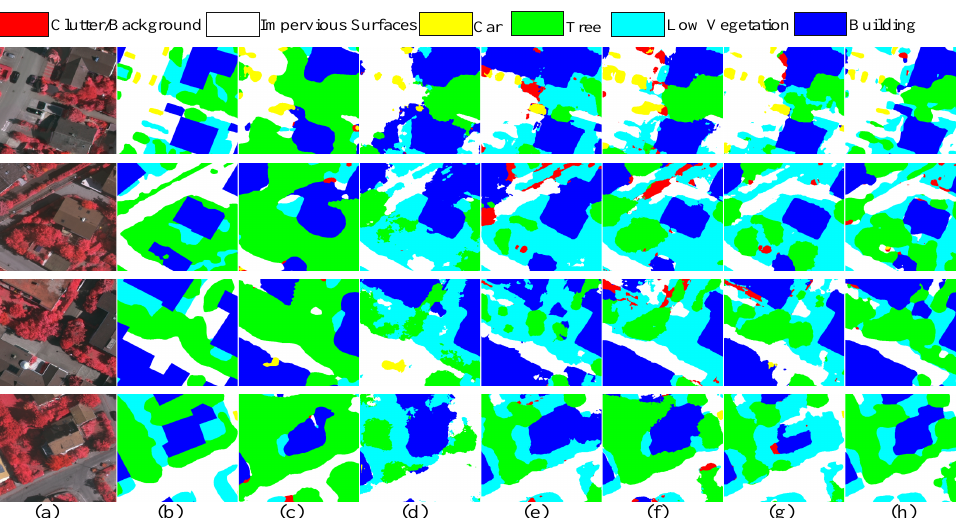
Figure 5. The qualitative results of the cross-domain semantic segmentation from PotsdamRGB to Vaihingen. ( a ) Target images. ( b ) Labels. ( c ) Baseline (DeeplabV3 [43]). ( d ) Benjdira’s [26]. ( e ) DualGAN [33]. ( f ) AdaptSegNet [18]. ( g ) MUCSS [12]. ( h ) ResiDualGAN + OSA